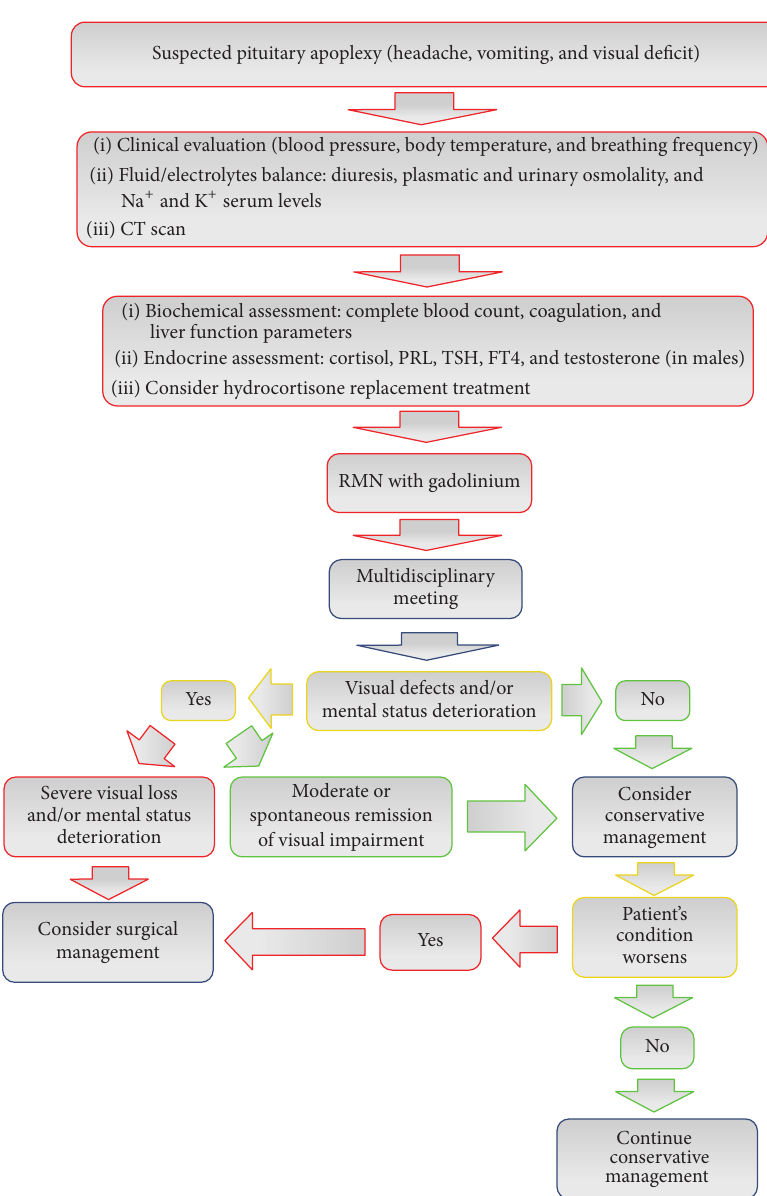
Figure 5: Algorithm for the management of pituitary